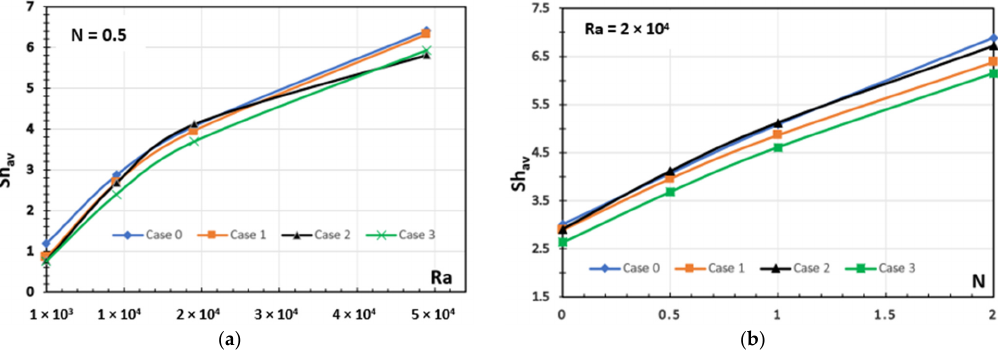
Figure 8. Effect of Rayleigh number ( a ) and buoyancy ratio for Ra = 2 × 10 4 ( b ) on the average mass transfer rate in all cases for θ = 0°.